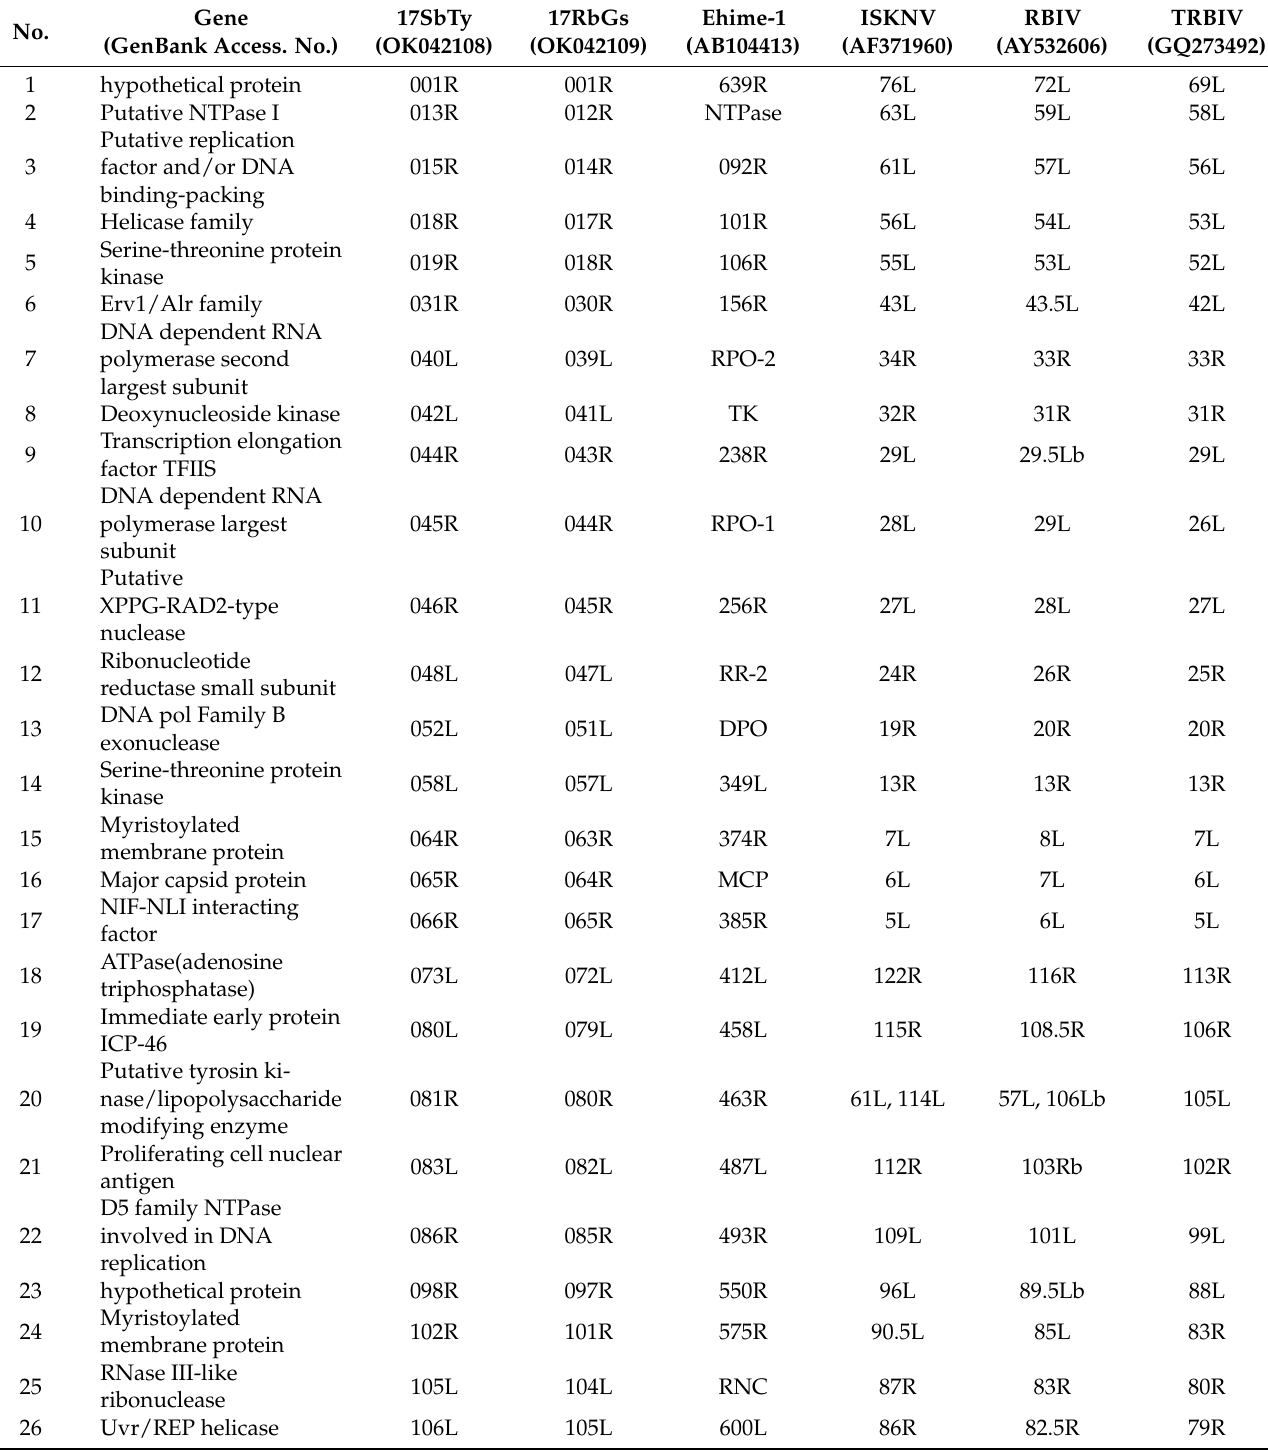
Table A4. ORF locations of the 26 conserved core genes conserved in the family Iridoviridae